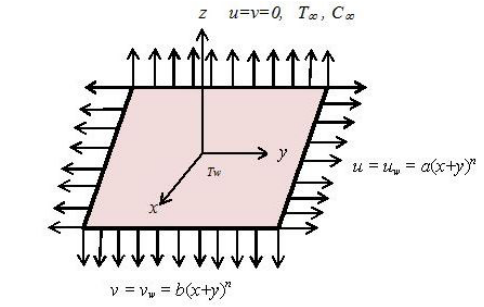
Fig. 1: Physical model and coordinate system